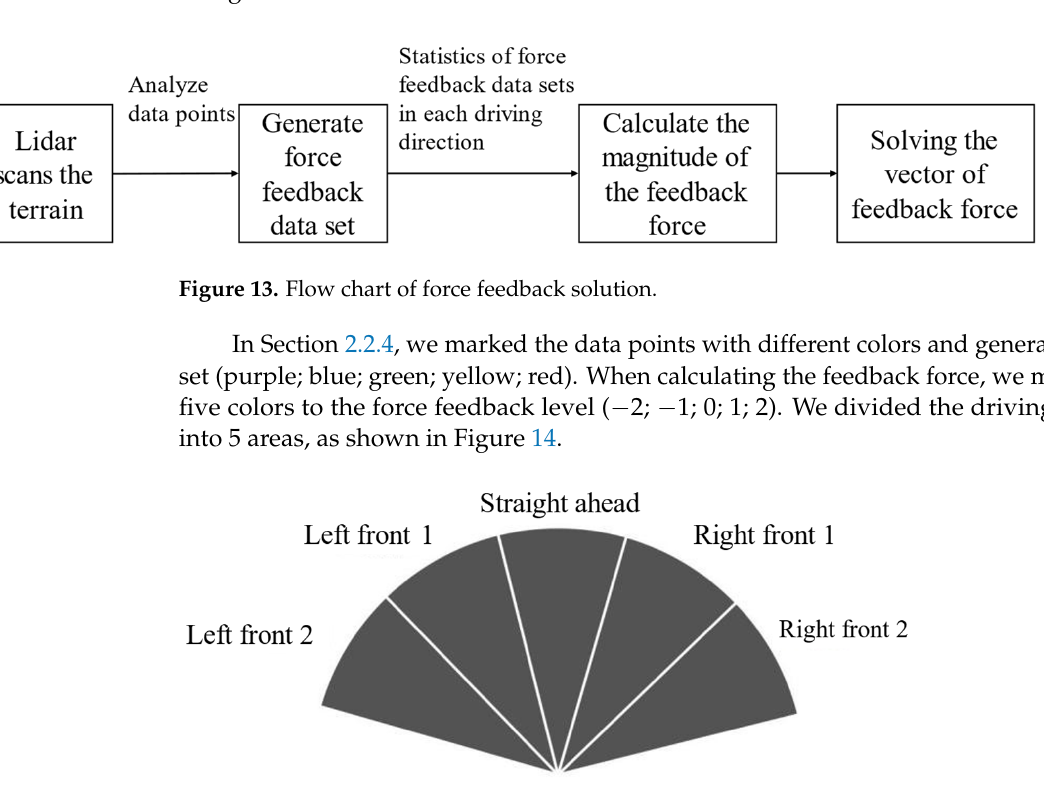
Figure 12. Structure of the multi-channel interactive system.